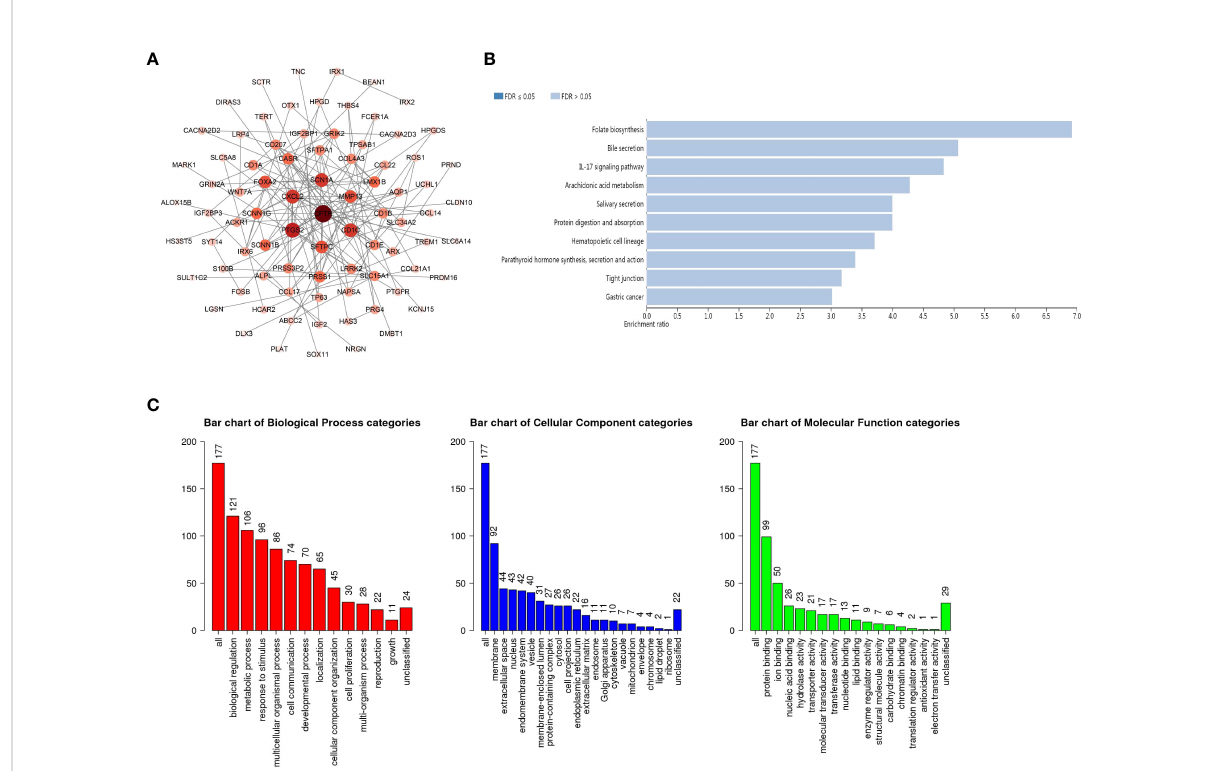
FIGURE 5 PPI network and the biological pathways of GSDM family members. (A) STRING and Cytoscape were used to build the PPI network. The WebGestalt database was used for the GSDM-related co-expressed molecules to analyze the GO functional enrichment analysis (B) and the KEGG pathway analysis (C)